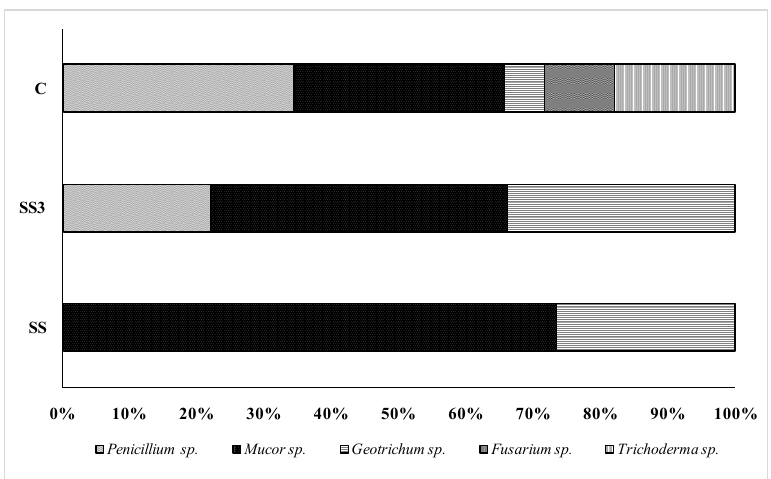
Figure 8. Relative distribution of fungal communities in particular soils: control soil (C), soil under sewage sludge accumulation (SS) and soil 3 m from the sewage sludge landfill